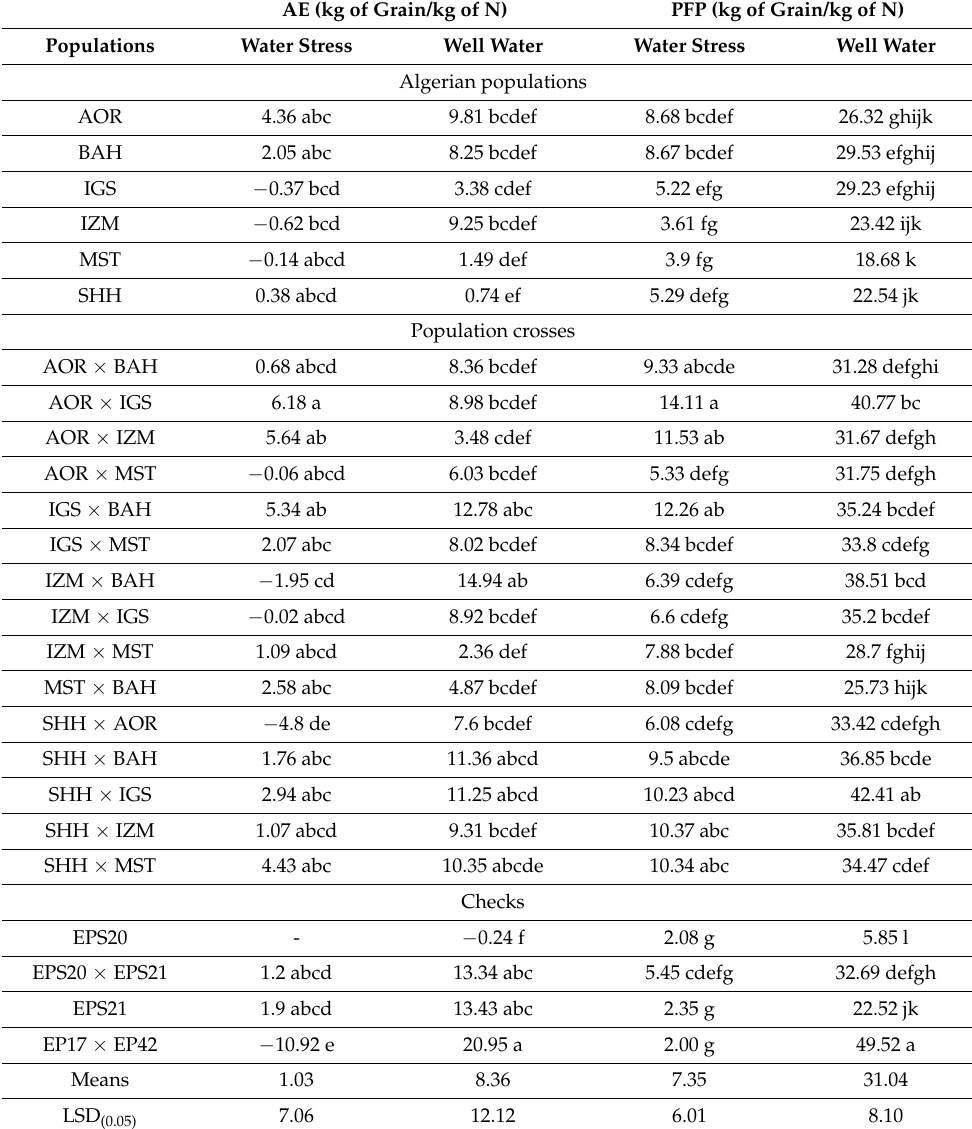
Table 6. Means a of agronomic efficiency (AE) and partial factor productivity (PFP) analyzed in the diallel systems with six Algerian maize populations evaluated along with four checks in two environments in Algiers under drought and nitrogen